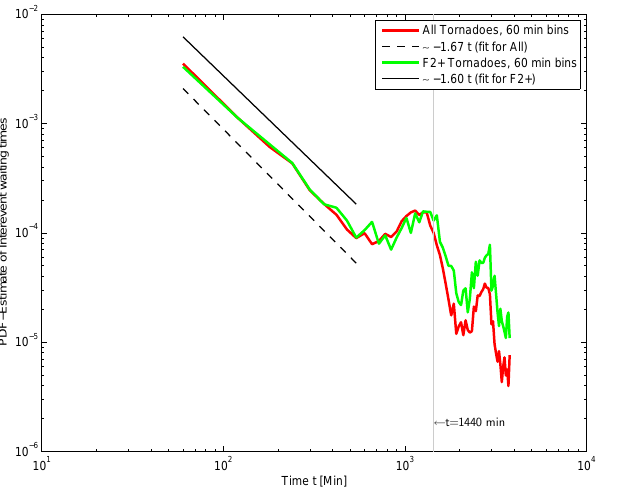
Fig. 3a. Short time analysis of interevent waiting times for all tor- nadoes (1950–2006, USA, red curve) and for tornadoes with Fujita intensities larger than or equal to F 2 ( F 2+ tornadoes, 1950–2006, USA, green curve), based on 60min bins. Linear fits have been ap- plied to the double-logarithmic plotted data in the range of 60 to 600min with slopes of − 1 . 67 for all tornadoes (black dashed line) and − 1 . 60 for F 2+ tornadoes (black solid line). The time line of 1440min (equal to 1 day) is highlighted by the grey vertical line in the plot.